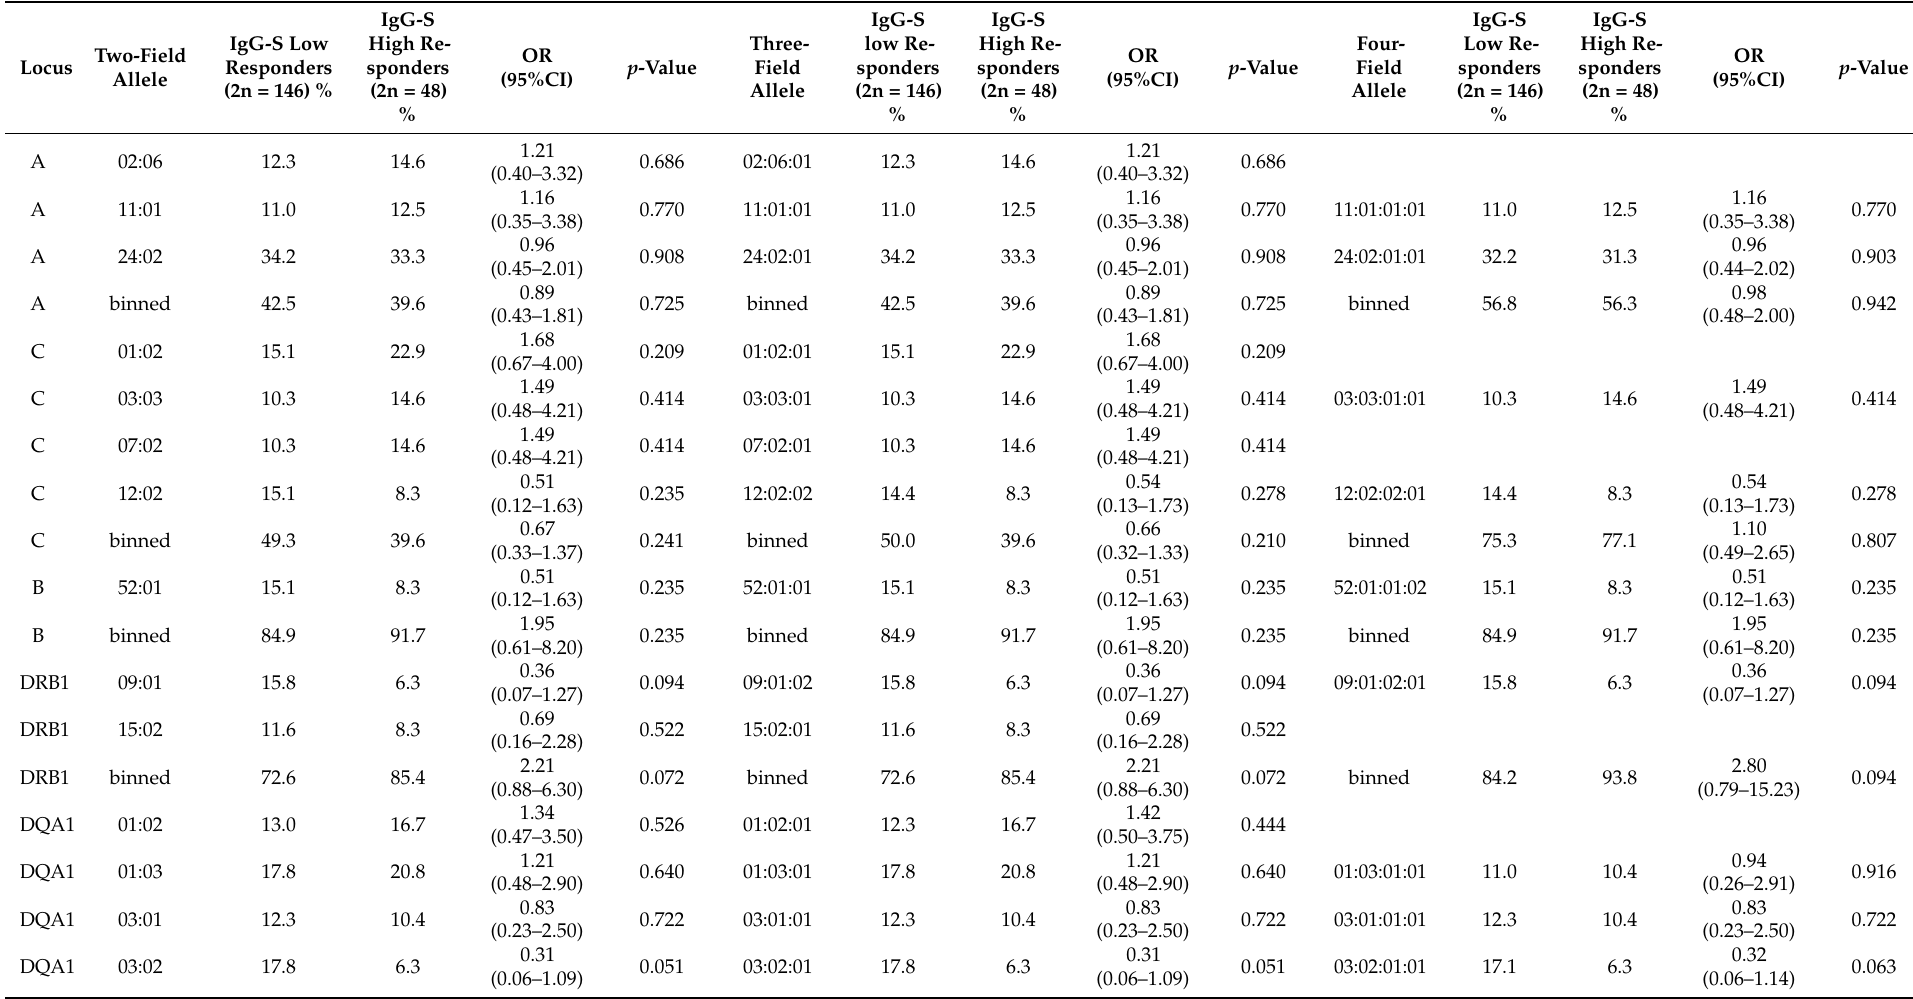
Table 2. Associational analysis of HLA-A, -C, -B, -DRB1, -DQB1, -DOA1 and -DPB1 alleles in 73 IgG-S low responders and 24 IgG-S high responders. Significant HLA alleles are highlighted. Abbreviations: OR, odds ratio; 95%CI, 95% confidence interval; binned, rare HLA alleles with expected count <5 are combined into a common